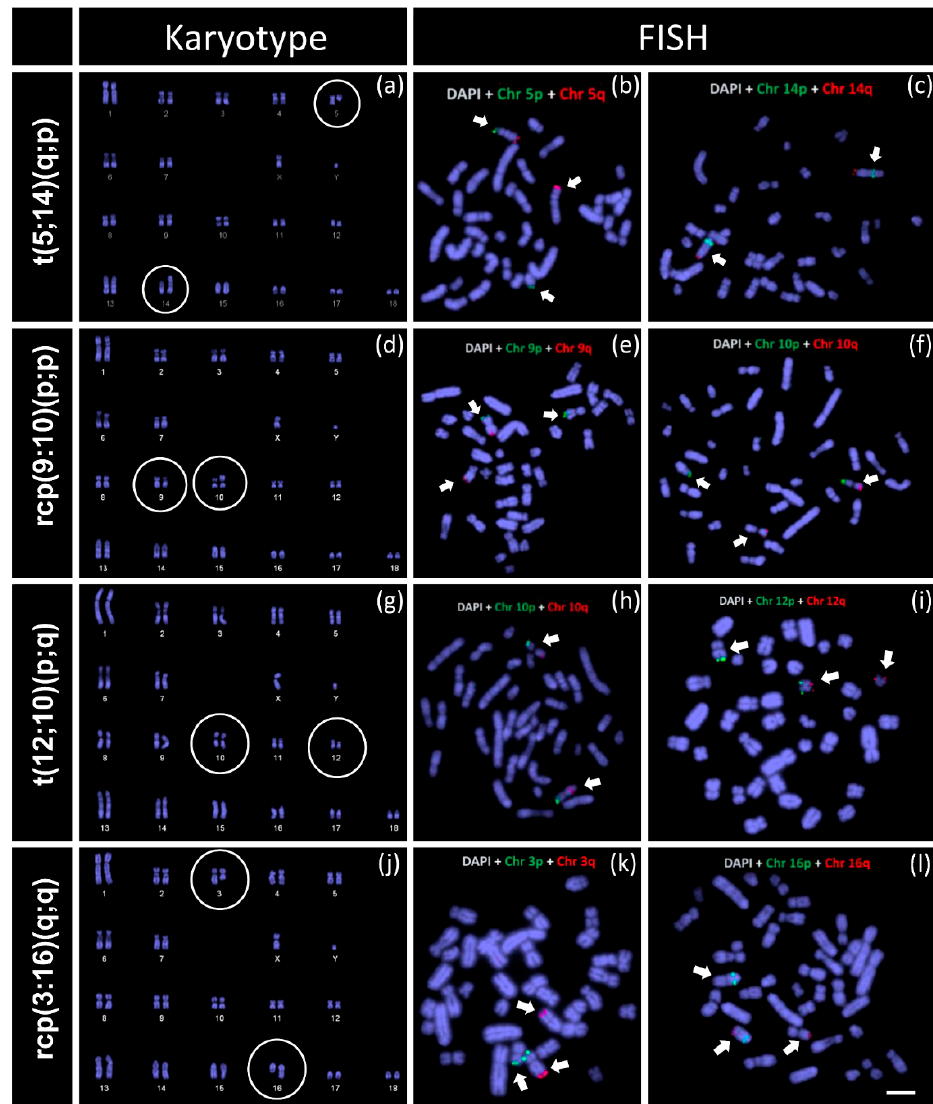
Figure 3. Karyotype and fluorescence in situ hybridisation (FISH) mapping of chromosome-specific subtelomeric genes in Australian boars. ( a ) DAPI-stained karyotype of t(5;14)(q;p); ( b ) FISH signals for chromosome 5-specific probes; ( c ) FISH signals for chromosome 14-specific probes; ( d ) DAPI-stained karyotype of rcp(9:10)(p;p); ( e ) FISH signals for chromosome 9-specific probes; ( f ) FISH signals for chromosome 10-specific probes; ( g ) DAPI-stained karyotype of t(10:12)(p;q); ( h ) FISH signals for chromosome 10-specific probes; ( i ) FISH signals for chromosome 12-specific probes; ( j ) DAPI-stained karyotype of rcp(3:16)(q;q); ( k ) FISH signals for chromosome 3-specific probes and ( l ) FISH signals for chromosome 16-specific probes. Scale bar 10 µ